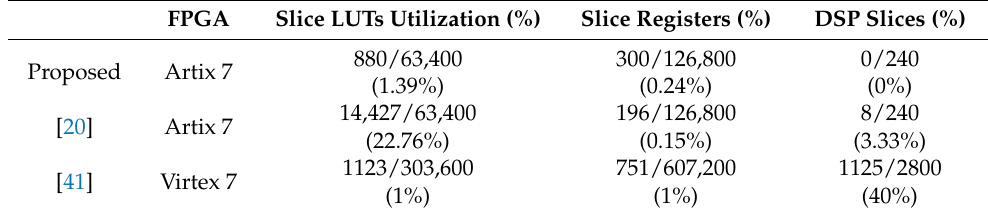
Table 4. Area occupation comparison with other